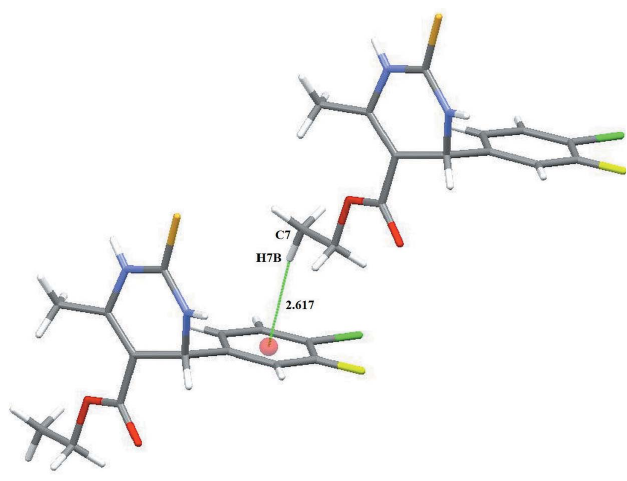
Figure 2 Unit-cell packing of the title compound, showing N—H (cid:3)(cid:3)(cid:3) O and N— H (cid:3)(cid:3)(cid:3) S interactions as dotted lines. H atoms not involved in hydrogen bonding have been excluded. See Table 1 for symmetry codes.